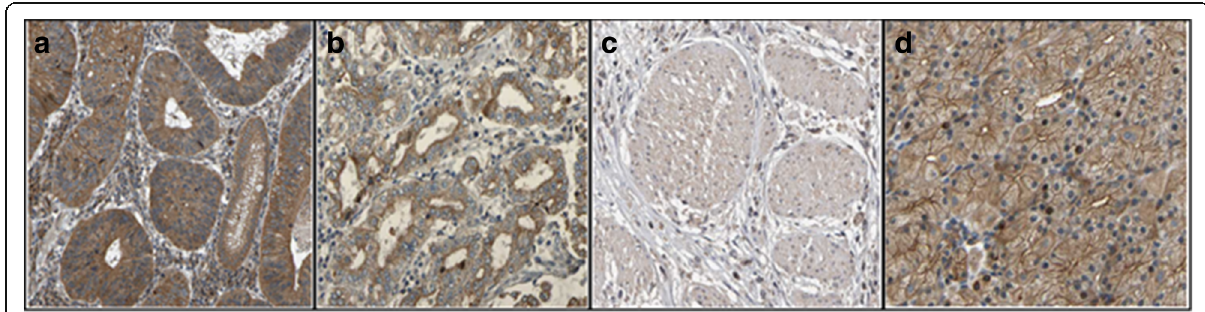
Fig. 1 Microscopic view of well differentiated adenocarcinoma of gastric tumor cells. a Positive high immunoexpression of anti-APC antibody in cancer cell ( b ) Positive moderate immunoexpression of anti-APC antibody in cancer cell ( c ) Negative immunoexpression of anti APC antibody in cancer cell ( d ) Positive moderate immunoexpression of anti-APC antibody in adjacent normal cell (from negative immunoexpression cancer cell), represented by the brownish colour in the cytoplasm and membrane